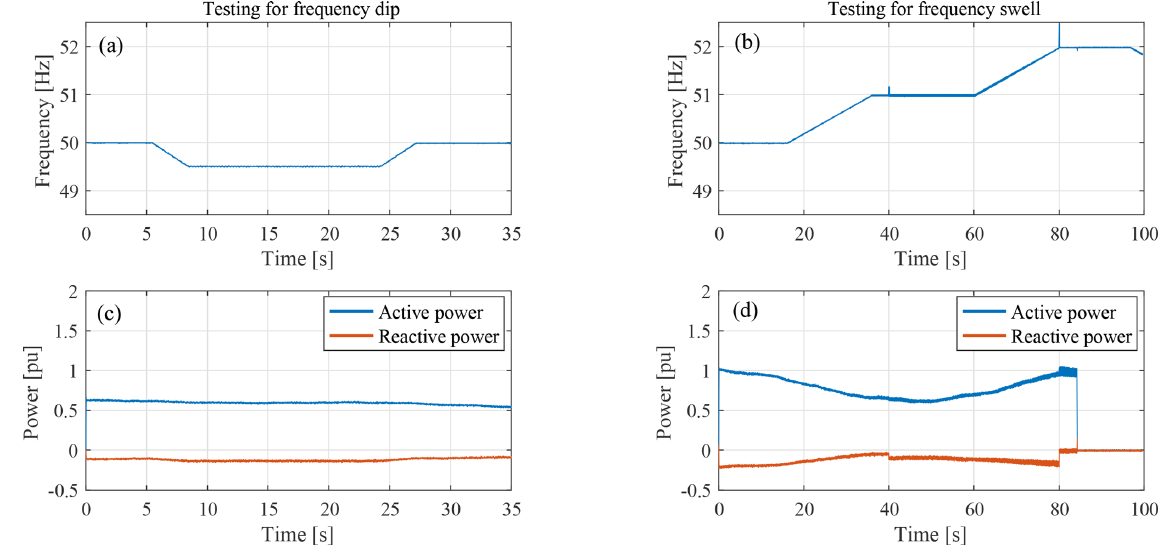
Figure 11. Frequency variation test, showing set points of active and reactive power during frequency dip (a, c) and frequency swell (b, d)